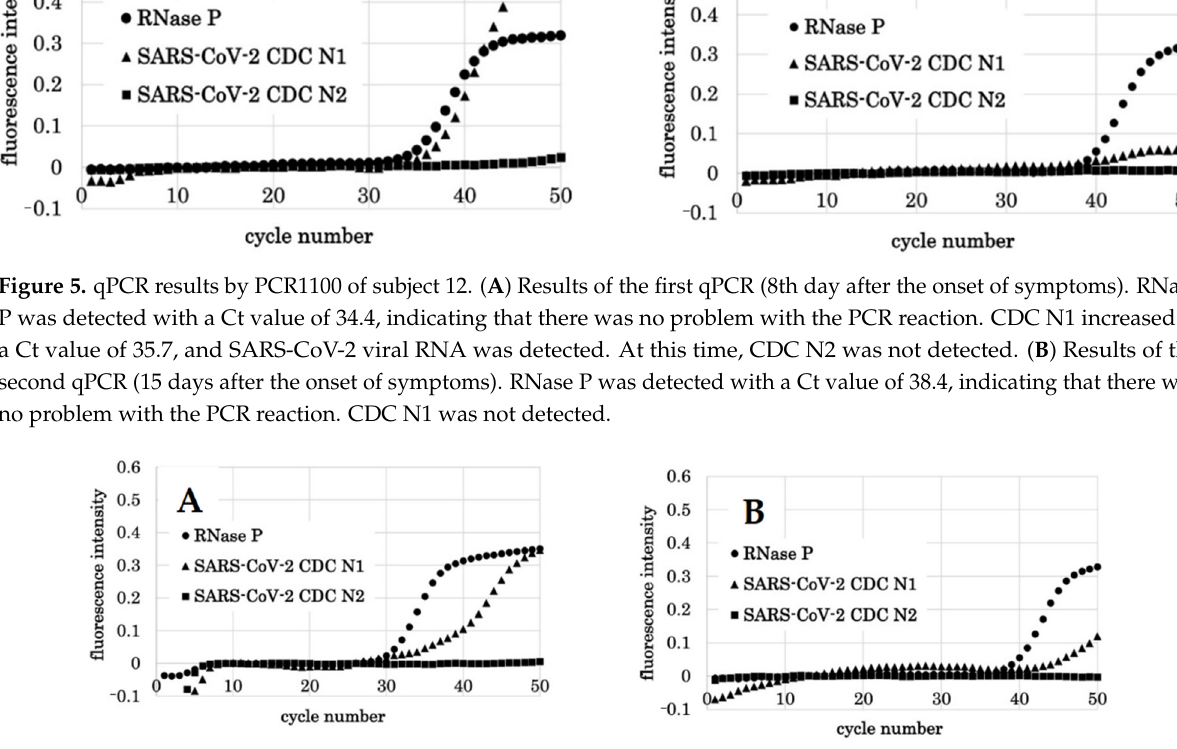
Figure 6. qPCR results by PCR1100 of subject 8. ( A ) Results of the first qPCR (3rd day after the onset of symptoms). RNase